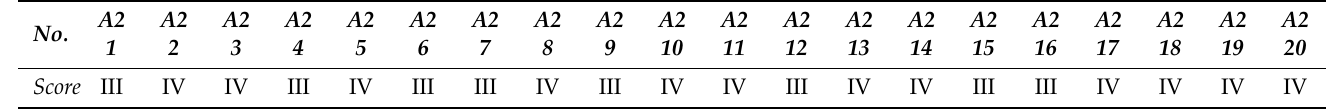
Table 4. Group A2: evaluation of the degree of dissolution of the